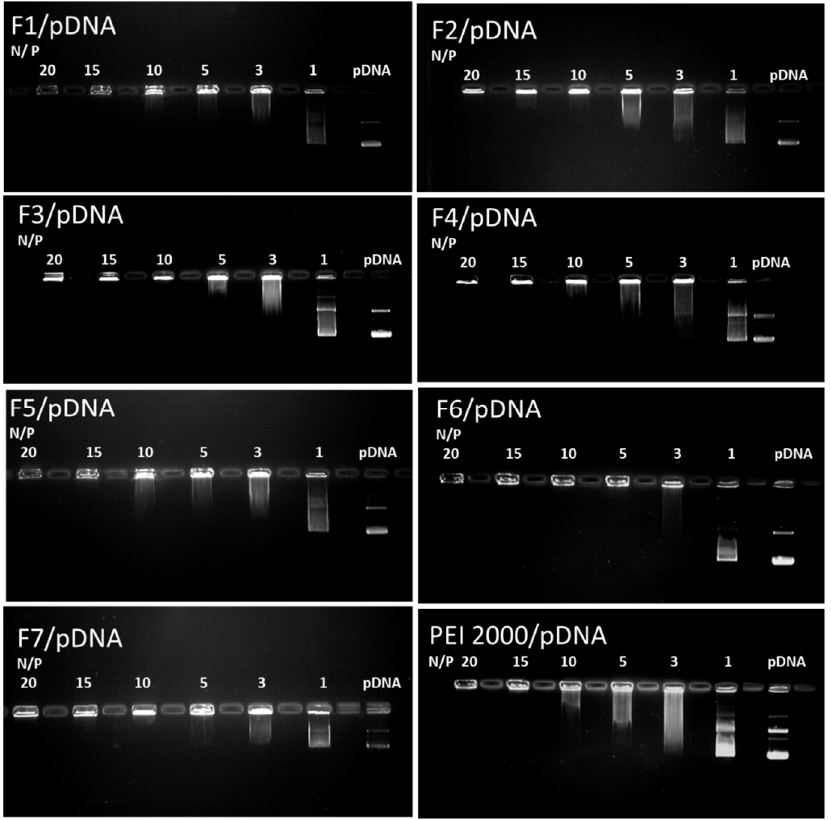
Figure 5. Images of agarose gel electrophoresis assays for F1–F7 compared to the reference PEI2000. Lane pDNA: naked DNA. Lanes 1–20: polyplexes F1-F7/pDNA, with the corresponding N/P ratios.